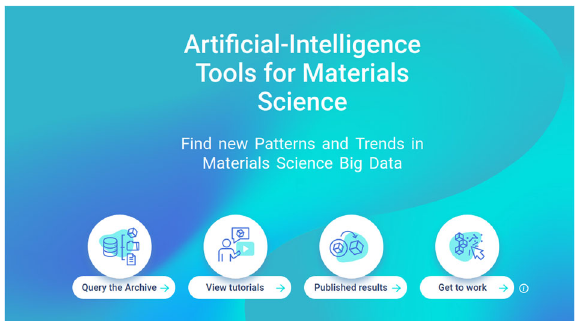
Fig. 1 Home page of the NOMAD Arti fi cial-Intelligence Toolkit. The homapage showcases the three purposes of the NOMAD AI toolkit: Querying (and analyzing) the content of the NOMAD Archive, providing tutorials for AI tools, and accessing the AI work fl ow of published work. The fourth access point, get to work, is for experienced users, who can create and manage their own